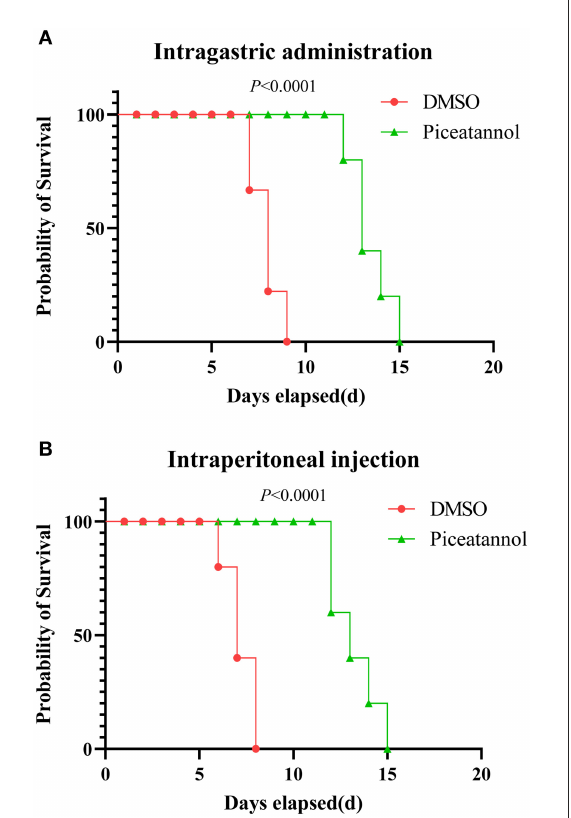
FIGURE3 Therapeutic effect of piceatannol on T. gondii infection in mice. BALB/c mice were infected with 500 tachyzoites by intraperitoneal injection. Then, mice were treated with 15 mg/kg piceatannol or DMSO by intragastric administration (A) or intraperitoneal injection (B) . The results show a therapeutic effect of piceatannol on mice infected with parasites. Statistical analysis was performed with survival curve of Graph Pad Prism using Log-rank (Mantel-Cox) test (San Diego,